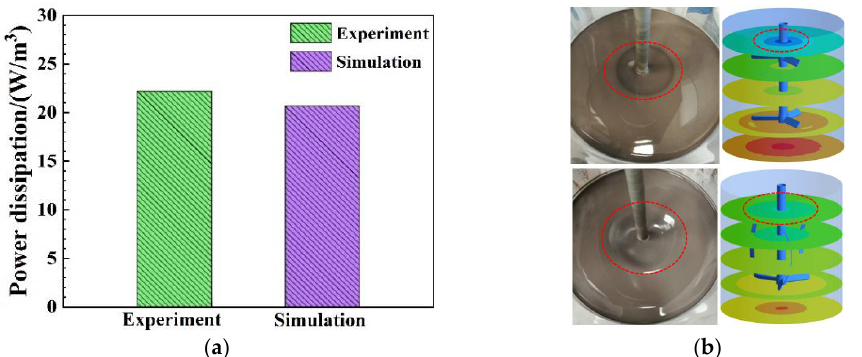
Figure 4. ( a ) Comparation of P v in the DRFTBI system between simulation and experiment; ( b ) comparation of solid distribution between the simulation and the experiment. (Rotational speed: 120 rpm; solid loading: 30%).